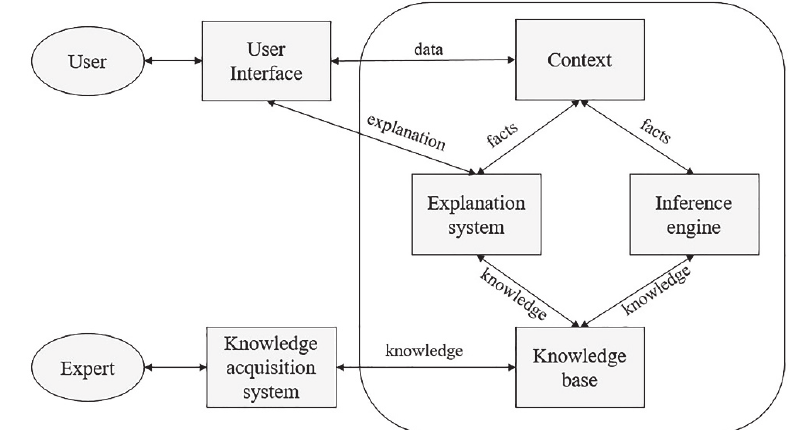
Fig. 2. Architecture of a traditional ES (source: modified of Krishnamoorthy and Rajeev